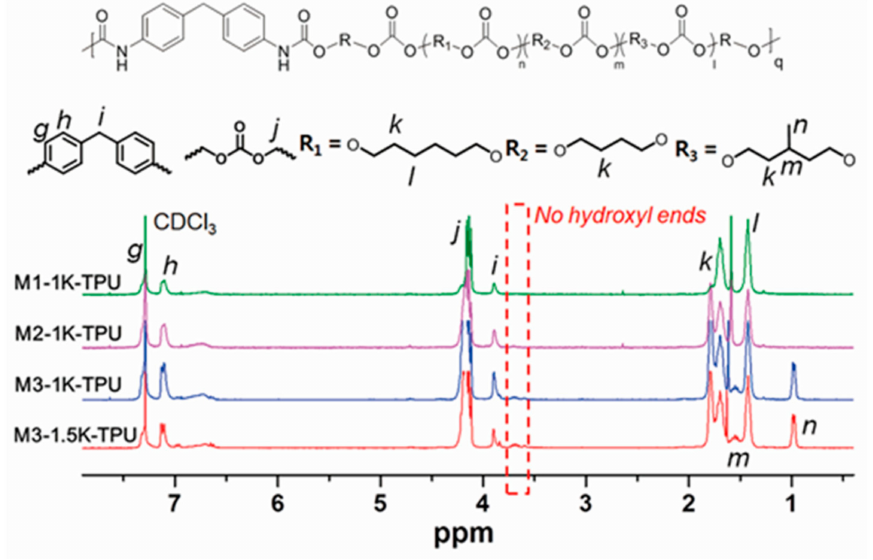
Figure 3. 1 H NMR spectra of TPUs in CDCl 3 (300